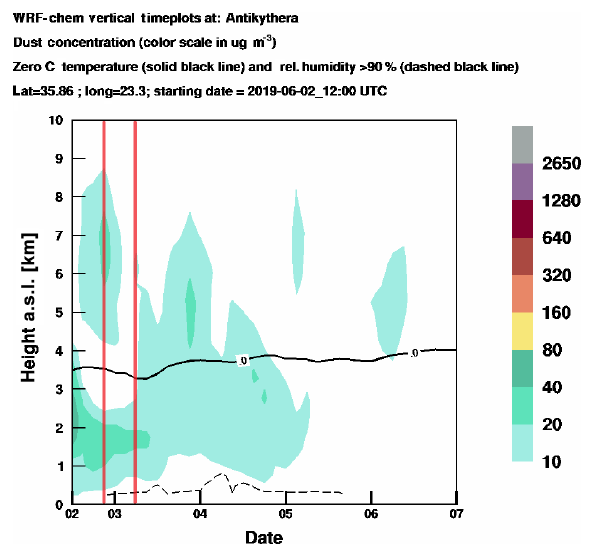
Figure 11. WRF-Chem time–height cross section of simulated dust concentration (µgm − 3 ) over Antikythera starting on 2 June at 12:00UTC. The solid black line is the 0 ◦ C isotherm, and the dashed black line indicates 90% relative humidity. The red lines correspond to the time domain of the lidar observations – i.e., from 21:00UTC on 2 June 2019 until 06:00UTC on 3 June